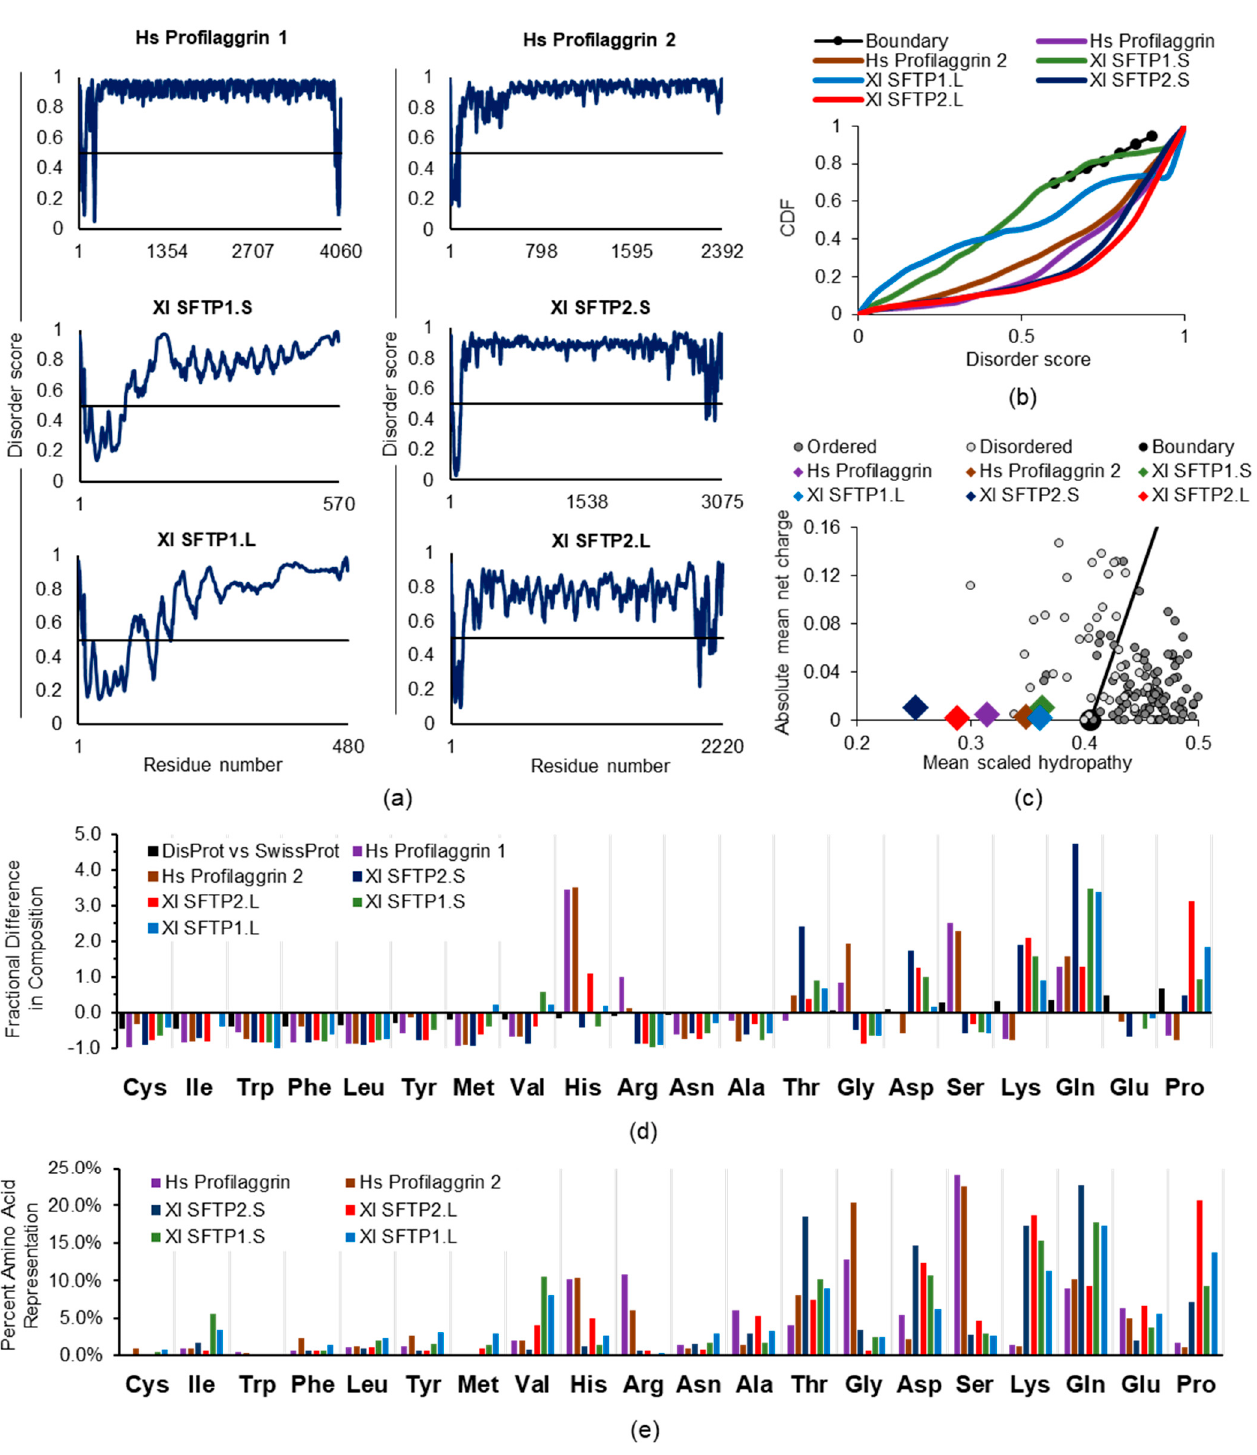
Figure 5. ID analysis of human profilaggrins 1 and 2, and four frog SFTPs. For explanations of panels ( a ) through ( e ), please refer to analysis as described in Figure 3’s legend. Human, Homo sapiens , Hs. Frog, Xenopus laevis , Xl.